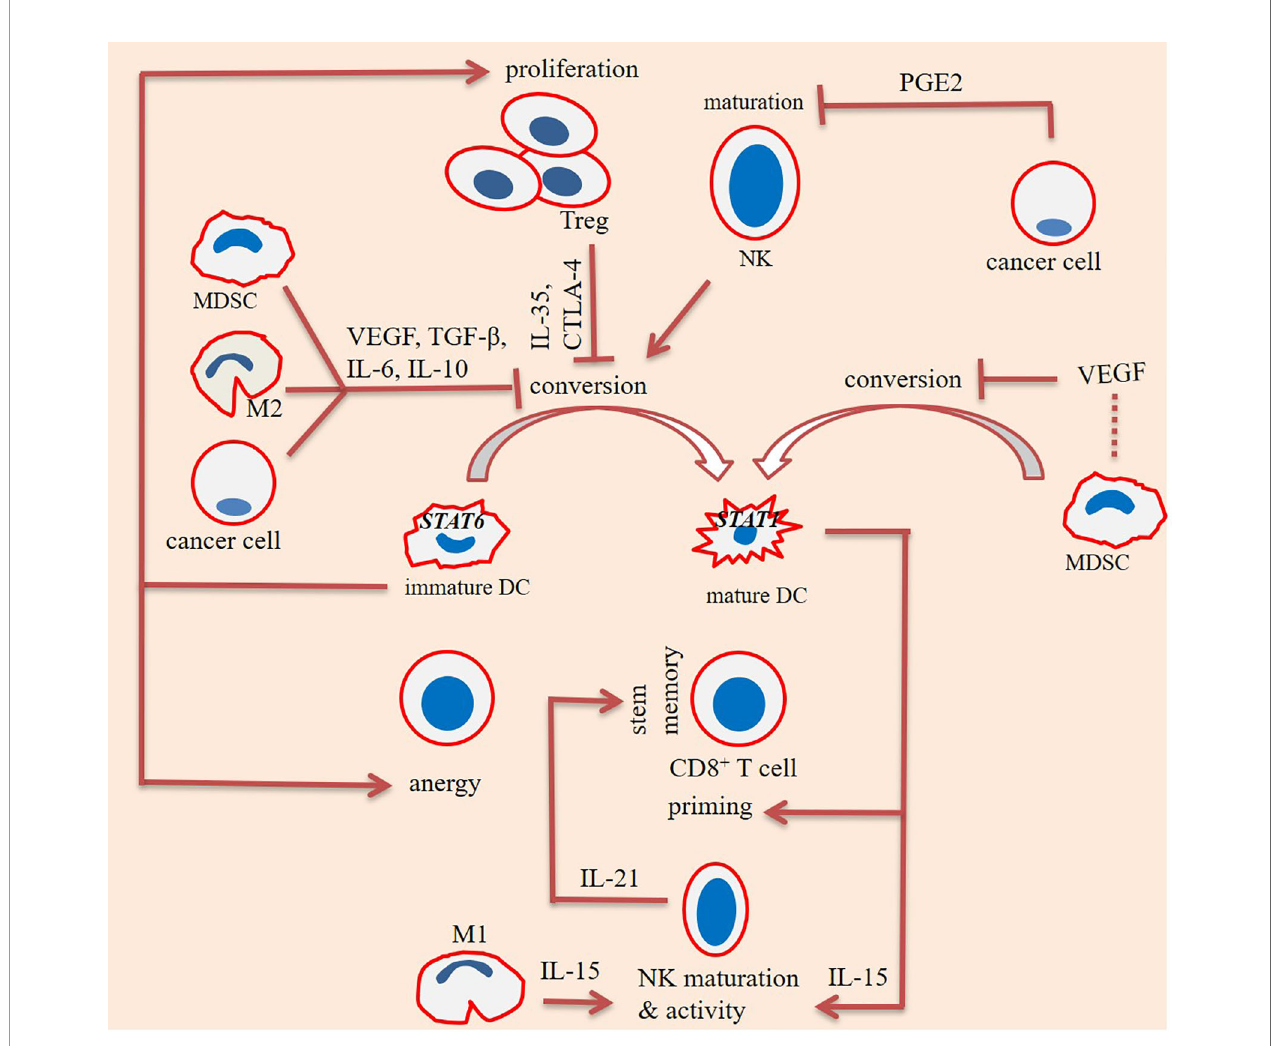
FIGURE 2 | Interactions among immune cells for promoting maturity/immaturity within the tumor immune ecosystem. Maturation of dendritic cells (DCs) is affected positively from the impact of natural killer (NK) cells, but negatively affected from the effects of cancer cells, regulatory T (Treg) cells, and myeloid-derived suppressor cells (MDSCs). Interleukin-10 (IL-10), cytotoxic T lymphocyte-associated antigen-4 (CTLA-4), and vascular endothelial growth factor (VEGF) are inhibitory factors released from cancer cells, Tregs, and MDSCs, respectively. IL-10 is also released from MDSCs and macrophage type 2 (M2) cells. Tregs impede DC maturation through CTLA-4 and IL-35. Immature DCs are signal transducer and activator of transcription 6 (STAT6) + and take tumor-promoting activities, mediated via enhancing Treg proliferation and stimulating T cell anergy. By contrast, mature DCs are STAT1 + and stimulate CD8 + T cell priming and NK cell effector function. Cancer cells release high levels of prostaglandin E2 (PGE2) upon exposure to hypoxia. PGE2 hampers maturation of NK cells. By contrast, maturation of NK cells is promoted by IL-15, released from DCs and M1 cells. NK cells further release IL-21 for promoting stem-like memory CD8 + T